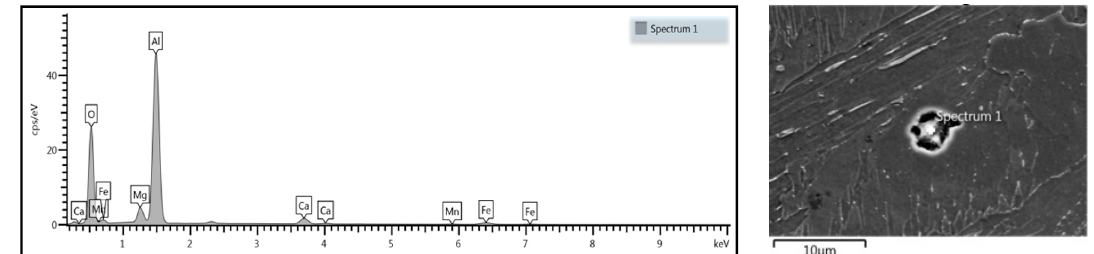
Figure 20. Spectroscopy analysis of identified aluminum oxide in the weld.